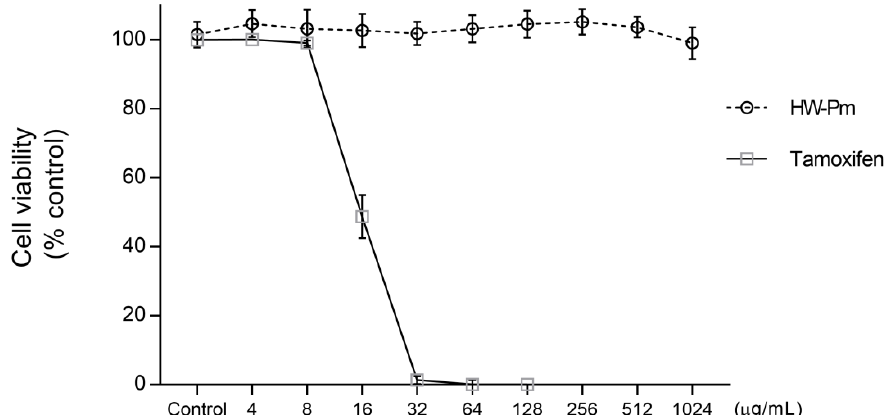
Figure 1. Effect of HW-Pm on RAW 264.7 murine macrophage cells’ viability. The effect of HW-Pm on the viability of RAW 264.7 cells was determined by the resazurin assay. All values are expressed as the arithmetic mean ± SD of six replicates. HW-Pm is the hot water extract from P. ostreatus and tamoxifen is a reference control drug for cytotoxicity.